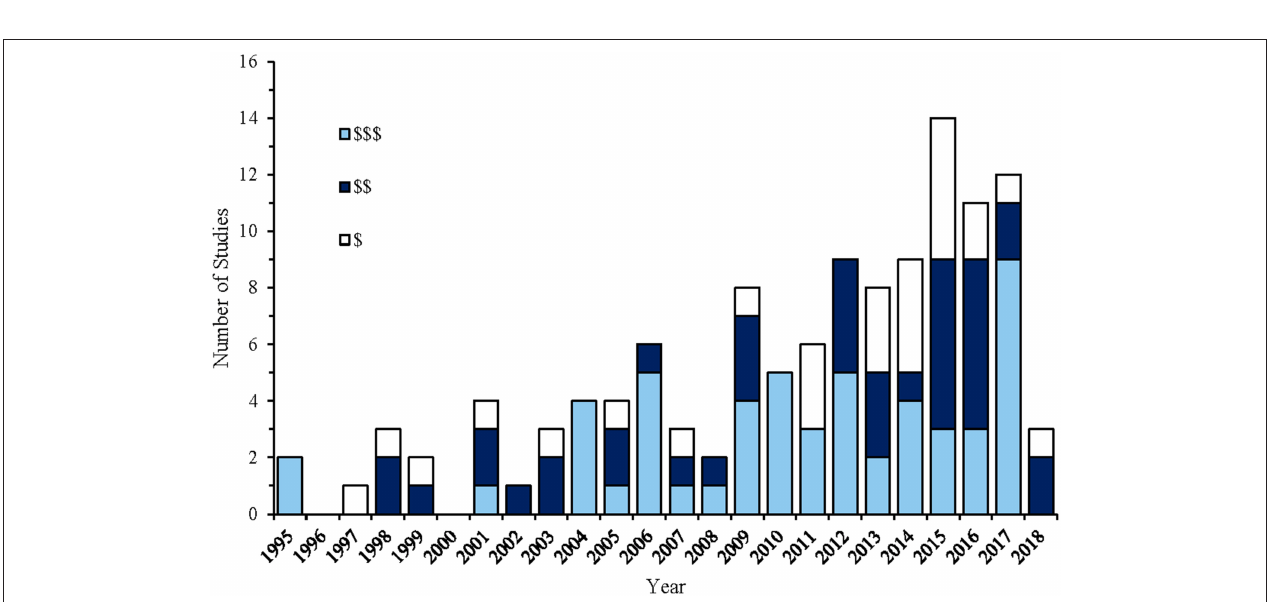
FIGURE 2 | Temporal trends in ROV publications using observation-class (Mini: White; Regular-sized: Light Gray), and working-class (Light: Dark Blue; Heavy: Light Blue) ROV systems to visually assess fish assemblages.